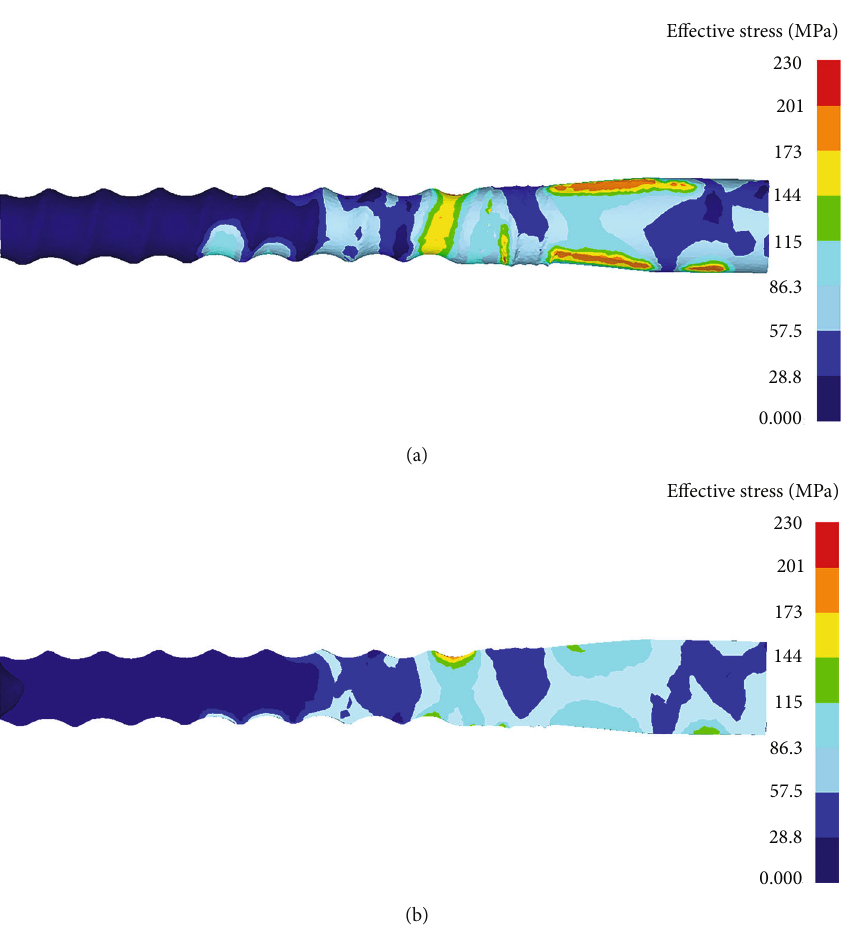
Figure 10: Distribution of e ff ective stress on the (a) surface and in the (b) center of the